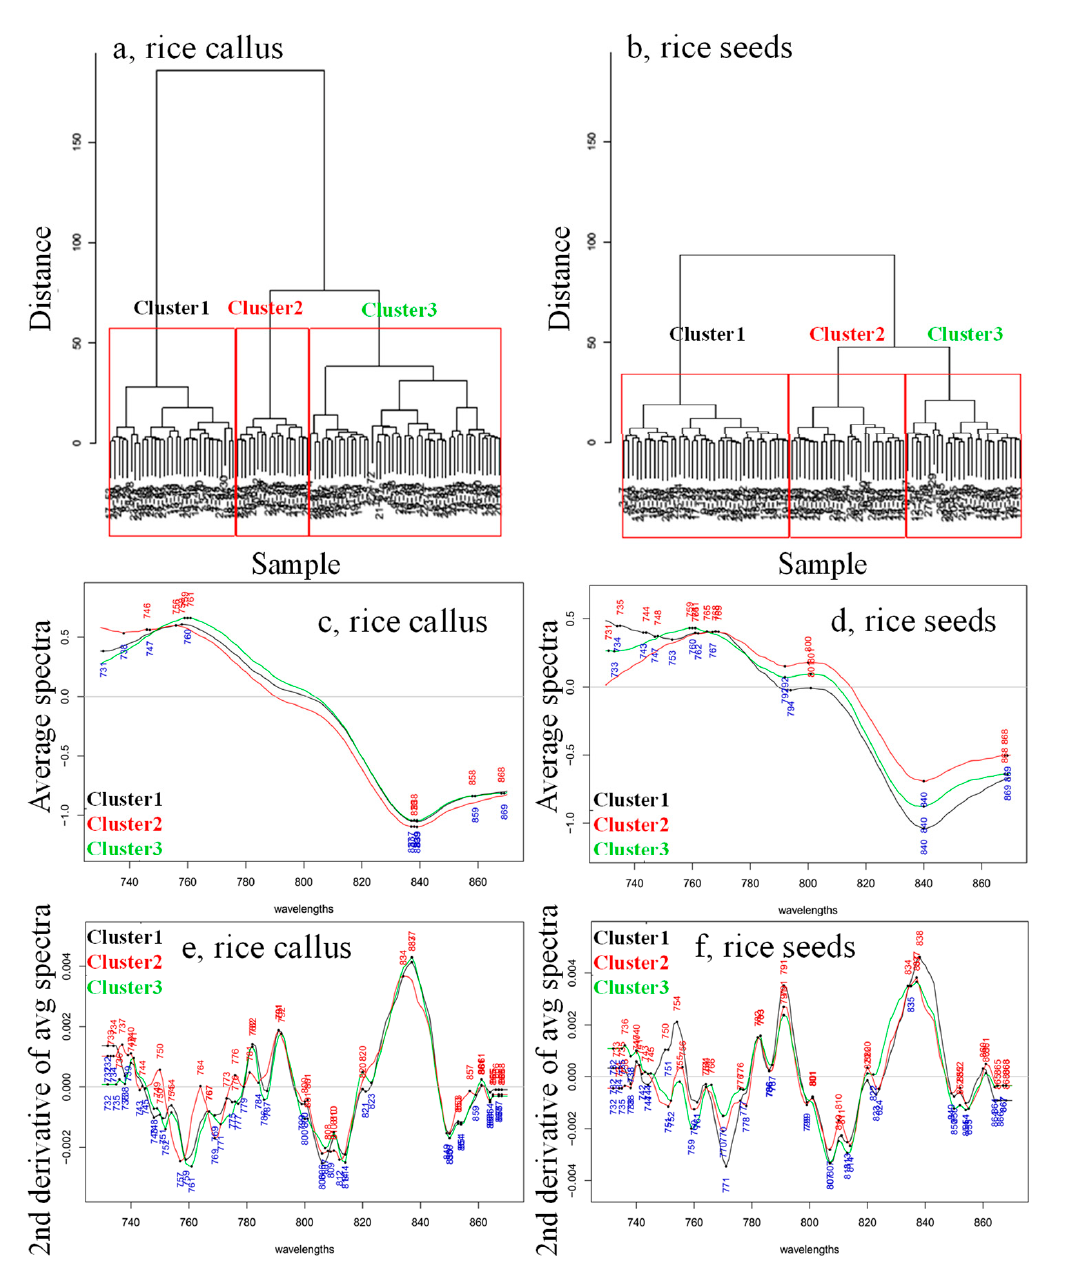
Figure 5. Hierarchical cluster analyses dendrogram calculated on the smoothed (calculated with Savitzky–Golay filter using 2nd order polynomial and 31 points), SNV- and linear detrend-corrected transmittance spectra acquired on the 10th day of growing of ( a ) the 28 callus rice seeds and ( b ) the 28 somatic rice seeds. Average spectra calculated for each of the three clusters found via HCA analysis for the ( c ) callus rice seeds, ( d ) the somatic rice seeds and the 2nd derivative transformation of the averaged spectra for ( e ) callus rice seeds and ( f ) somatic rice seeds.